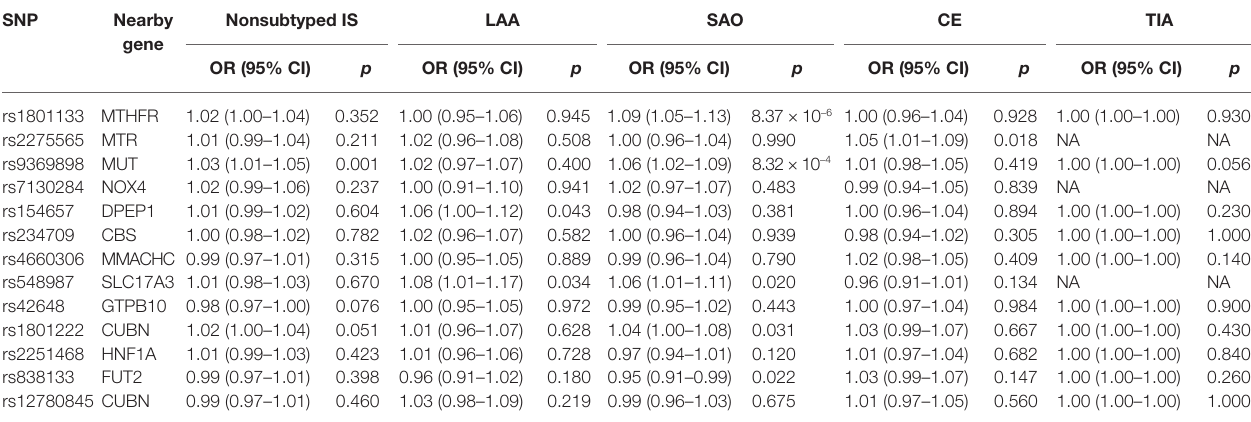
TABLE 1 | Main MR results of the effect of Hcy on cerebrovascular